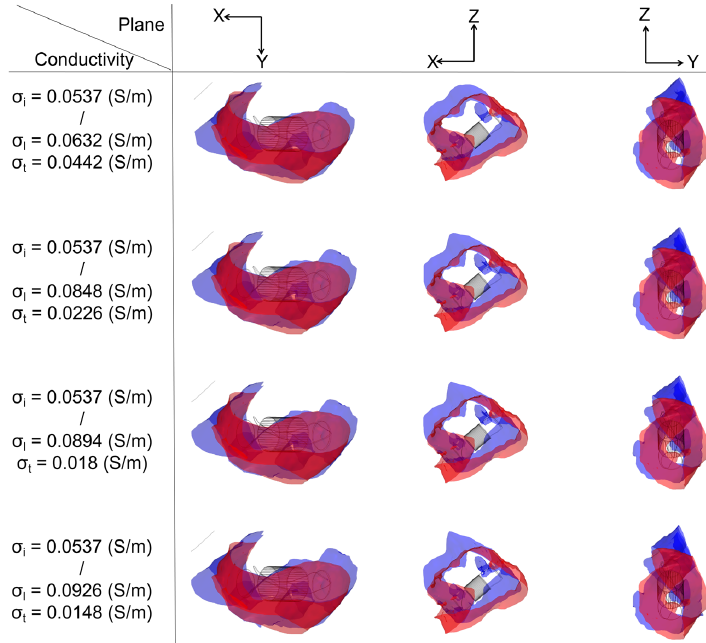
Figure 9. Under the condition of the PFA, the amplitude is 1000 V; at ablation target 1 the ablation isosurface distribution is generated by different ACs and ICs, where the ablation isosurface is defined as the electric field intensity equal to 1000 V/cm. The red area and blue area represent the ablation isosurface generated by IC and AC, respectively.